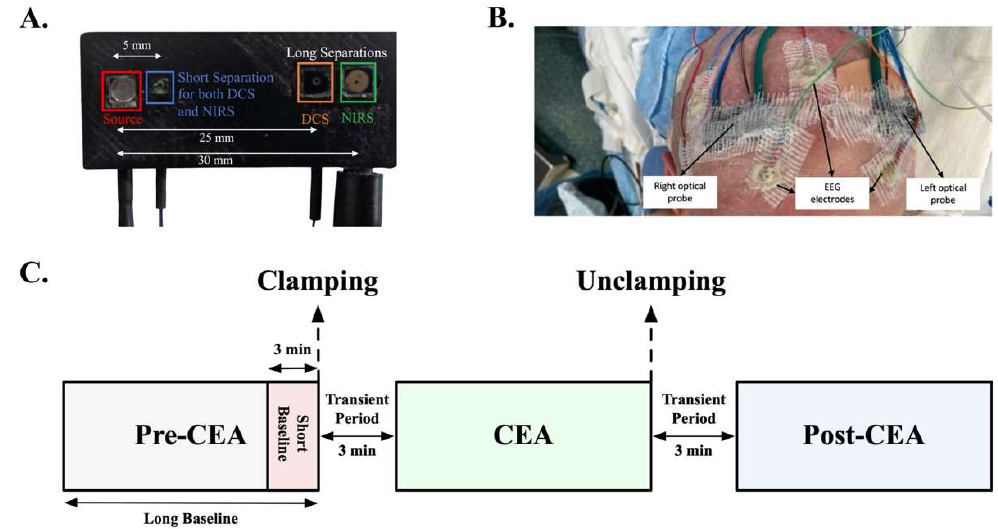
Figure 1. ( A ) The DCS-NIRS probe. The co-localized DCS and NIRS source fiber is marked by the red square. The co-localized DCS and NIRS short separation detector fiber (blue square) is located at 5 mm from the source. The short separation detector is employed to measure superficial (extracerebral) blood flow and hemoglobin oxygenation changes. A DCS long separation detector (orange square) is located at 25 mm (it includes three detectors to improve SNR), and a NIRS long separation detector (green square) is located at 30 mm from the source. Long separations are employed to measure cerebral blood flow and hemoglobin oxygenation. ( B ) The optical probes after bilateral placement on one patient in conjunction with EEG electrodes. ( C ) Schematic timeline of the surgery and data analysis phases. The signal average of a physiologically stable 3-min period immediately before clamping was used to normalize the data to quantify the transient ipsilateral changes of clamping and unclamping across patients (red shaded area, short baseline). The pre-CEA phase (gray and red shaded areas, long baseline) was used to normalize the data to quantify changes in the CEA (green shaded area) and post-CEA (blue shaded area) phases with respect to the pre-CEA phase. The 3 min of transient data between the two phases were discarded from the second analysis. Table 1. Measurement and patients’ clinical characteristics.